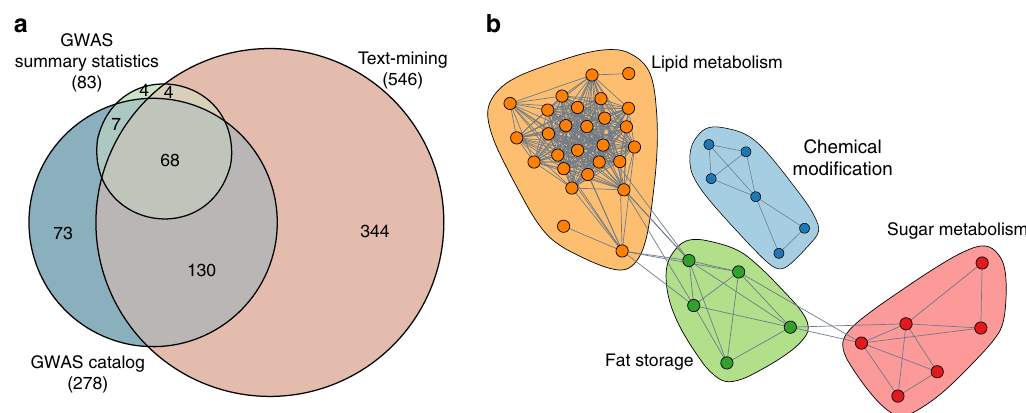
Fig. 2 Identi fi cation of MetSyn-related genes. a Venn diagram showing the overlap among MetSyn genes identi fi ed using GWAS catalog, GWAS summary statistics and text mining. See also Supplementary Fig. 2 and Supplementary Data 3. b Pathway enrichment map showing shared gene content among the pathways enriched in MetSyn genes. Each node corresponds to a pathway and edges between pathways indicate the presence of shared genes. Colors identify the membership to communities as detected by random walk clustering algorithm. See also Supplementary